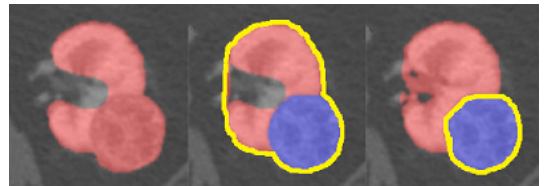
Figure 1. A kidney image prepared by manual segmentation.